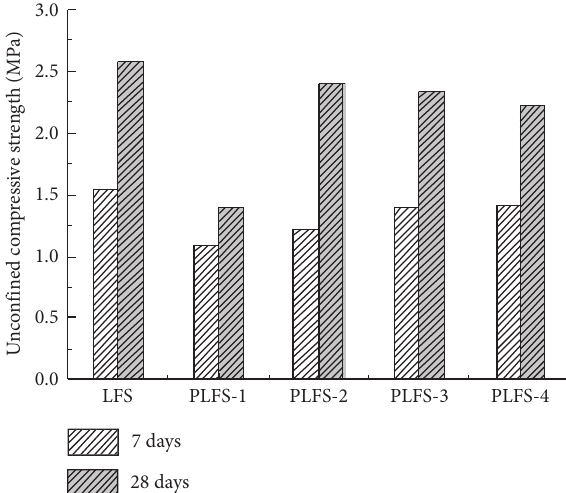
Figure 4: Compressive strength of various mixtures.